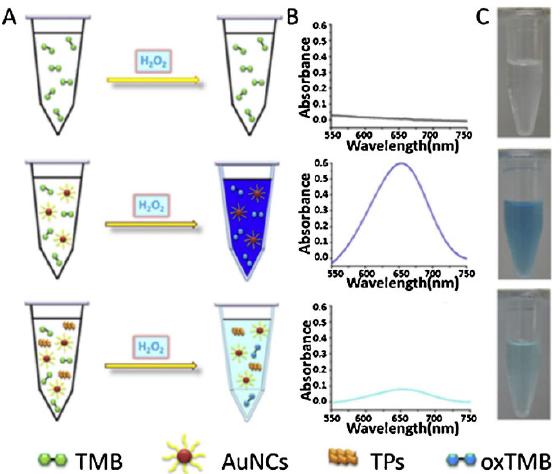
Figure 18. ( A – C ) Schematic strategy for the determination of tea polyphenols based on the partial inhibition HRP activity of the BSA–Au nanozymatic system in the presence of tea polyphenols. Reprinted with permission from [61]. Copyright © 2016 Elsevier.